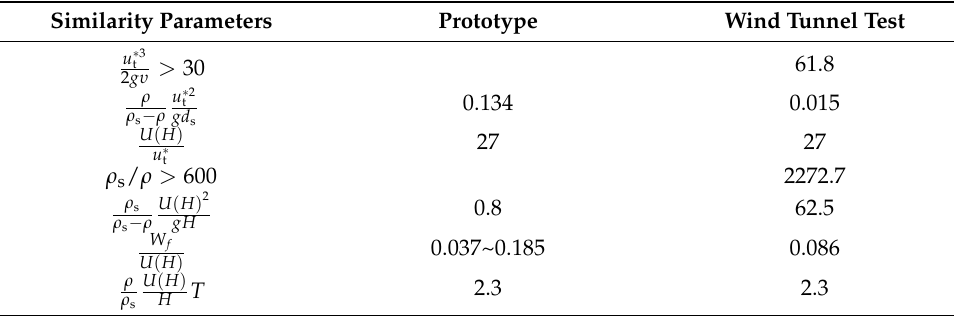
Table 3. Similarity